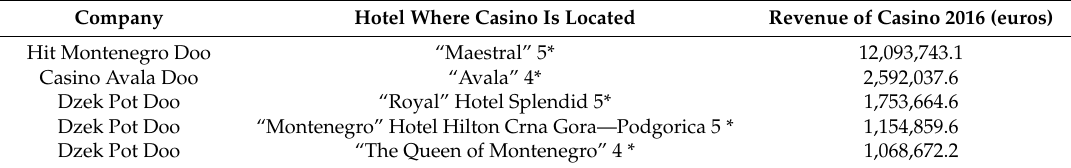
Table 3. Casino hotels in